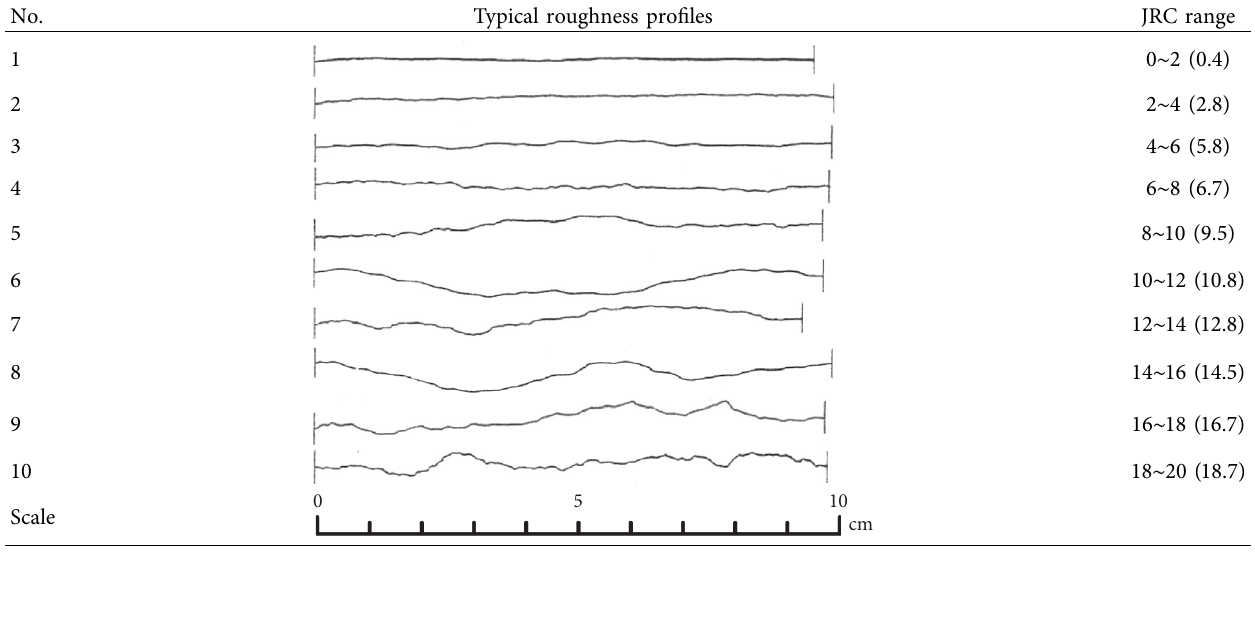
Table 1: 10 standard roughness joint profiles [9].